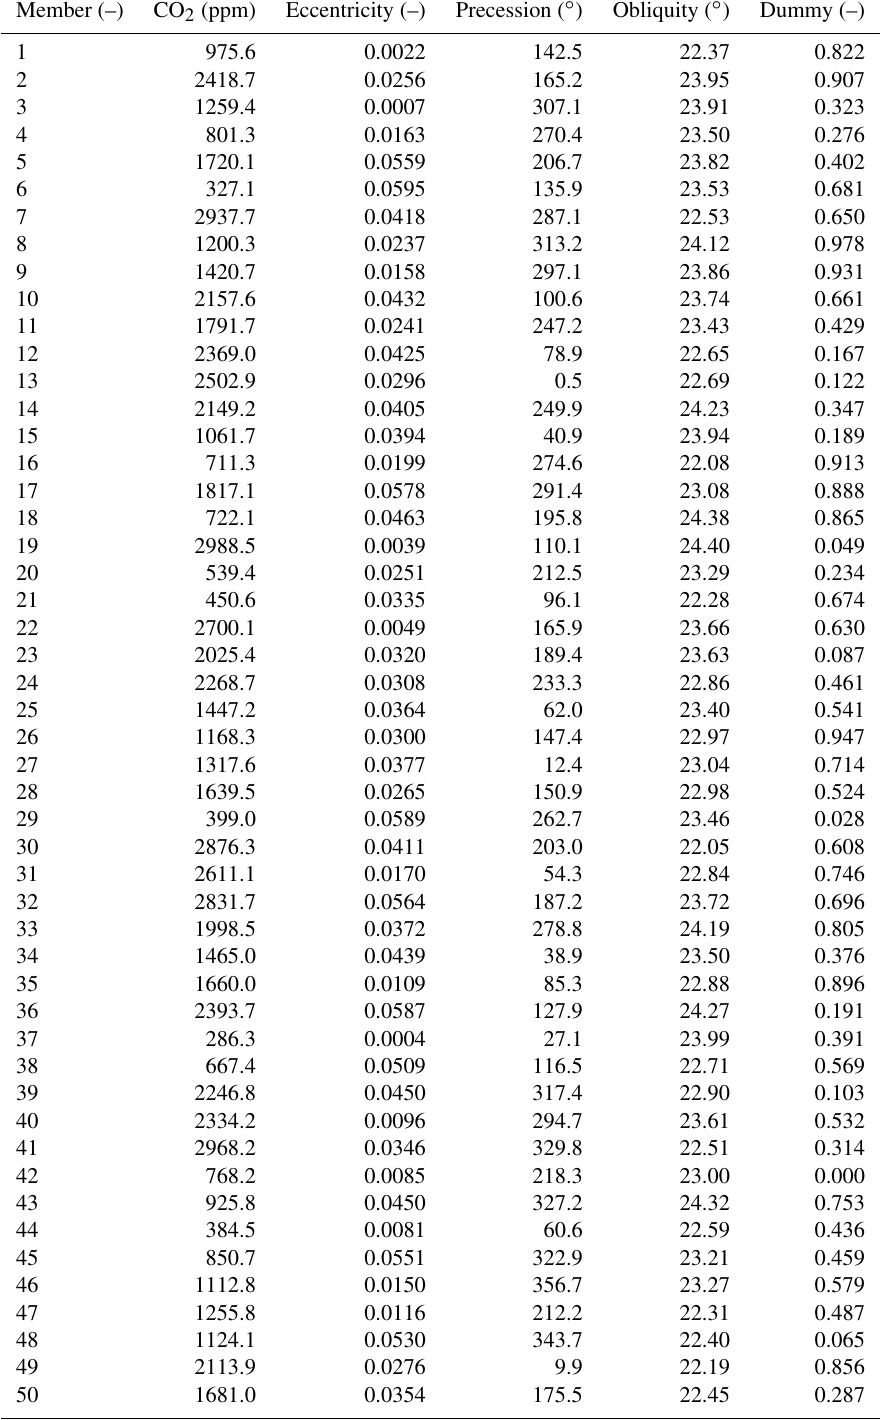
Table 2. Forcing factors and dummy values for each member in the ensemble. Precession is indicated by ω , the angle between the moving vernal equinox and the longitude of